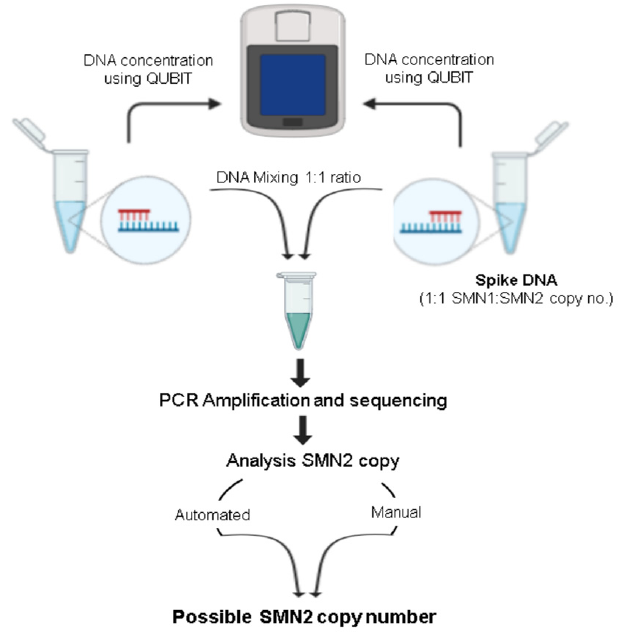
Figure 4. Flow diagram for determination of SMN2 copy number of SMA affected specimen. DNAs were measured using QUBIT, and equal amount of spike DNA and test DNA were mixed, followed by bidirectional sequencing.